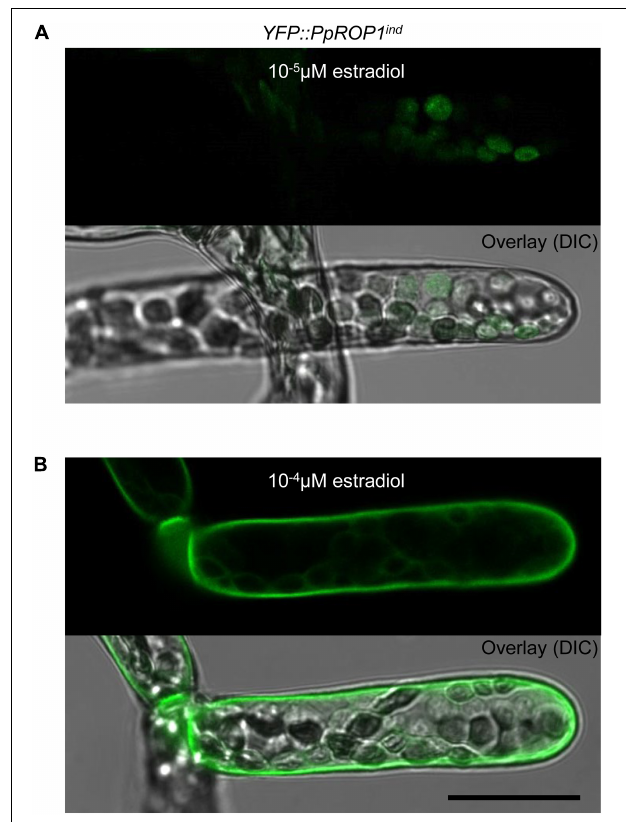
FIGURE 7 | Analysis of the intracellular distribution of YFP::PpROP1 expressed at different levels in apical cells of YFP::PpROP1 ind protonemata induced with 10 − 5 or 10 − 4 µ M estradiol. Upper panels in (A,B) : Medial confocal optical section through the tip of YFP::PpROP1 ind protonemal filaments grown in the presence of 10 − 5 µ M (A) or 10 − 4 µ M (B) estradiol. Only background chlorophyll autofluorescence also displayed by WT cells ( Figure 3A ) was visible after induction with 10 − 5 µ M estradiol (A) . At each of the two estradiol concentration tested, all imaged apical cells displayed essentially identical fluorescence emission patterns ( n = 20). Lower panels (Overlay) in (A,B) : fluorescence images shown in the upper panels overlaid onto transmitted light reference images (differential interference contrast, DIC). Scale bar = 25 µ